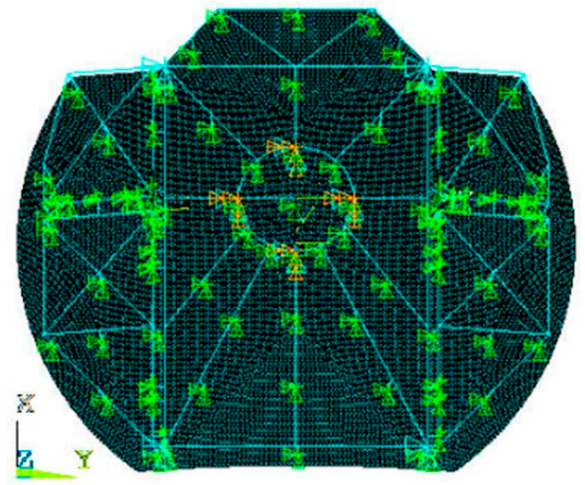
Figure 3. The finite element model of the antenna reflector.